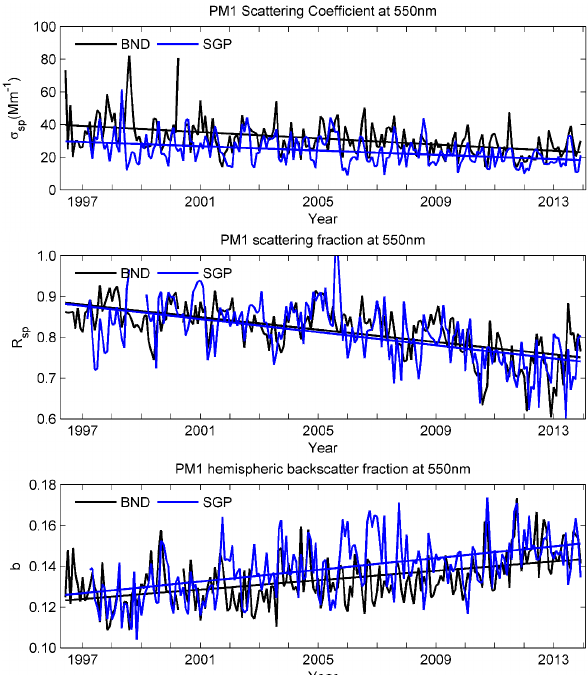
Figure 9. Time series of monthly averaged PM 1 σ sp , R sp , and b at 550nm for BND (1996–2013) and SGP (1997–2013). Trend lines, representing least-squared fits of the data, are also